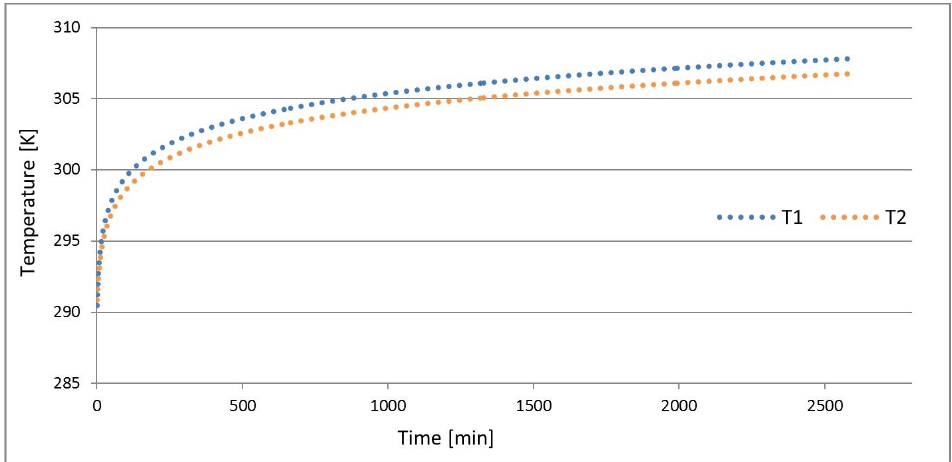
Figure 8. Evolution of inlet and outlet temperatures registered during the TRT.